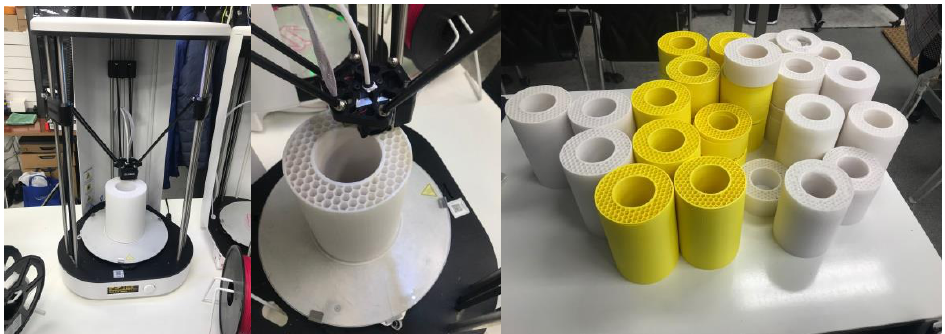
Figure 12. Manufacturing of in-plane honeycomb units with a three-dimensional (3D) printer.